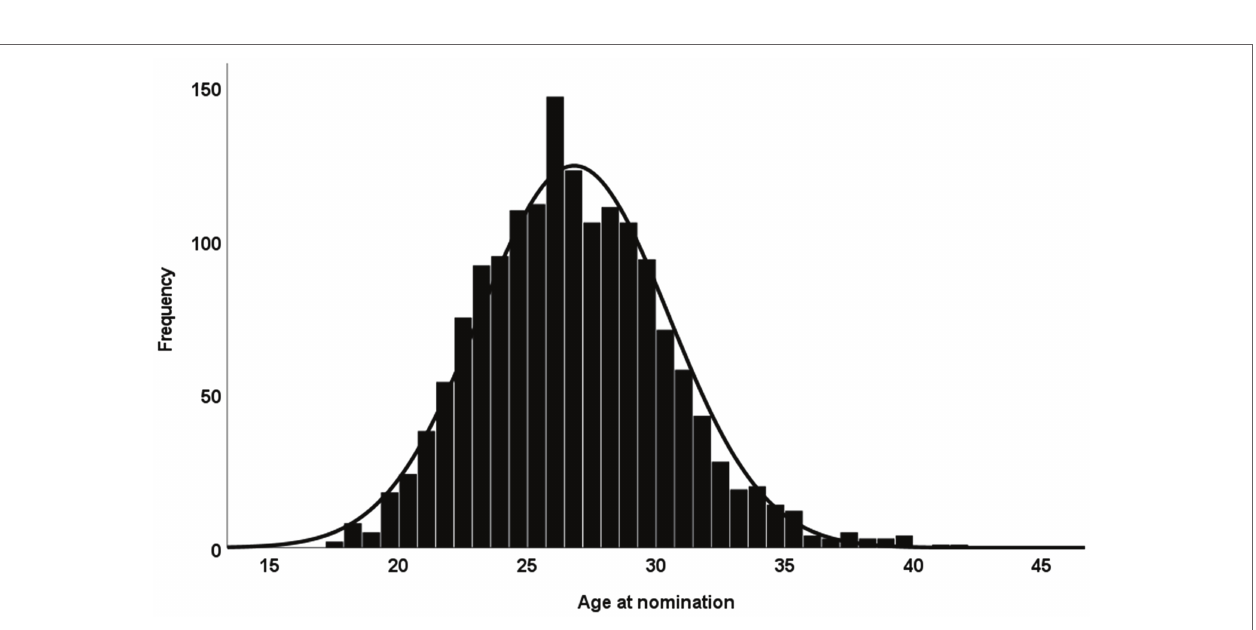
FIGURE 3 | Frequency of nominations at different ages for retired players’ last